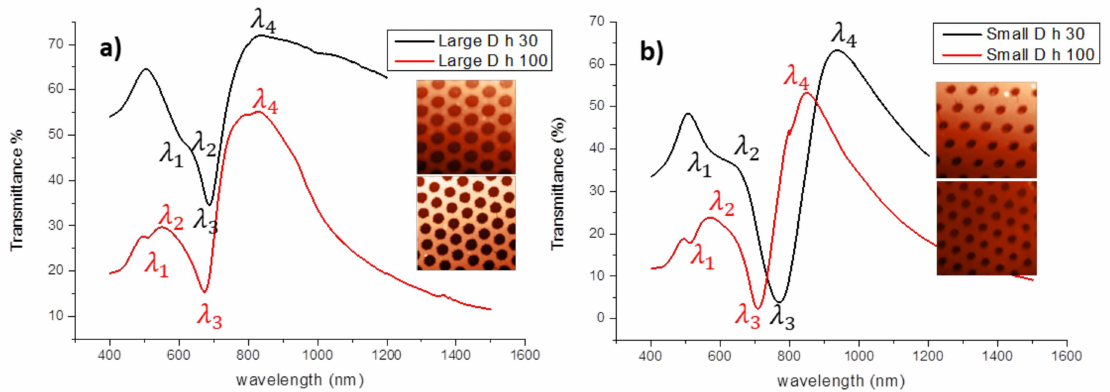
Figure 3. Optical transmittance spectra of the four samples in air, normalized to the signal of a bare glass substrate: ( a ) transmittance spectra of the large diameters nanoholes in gold film, 30 nm and 100 nm thick, respectively, ( b ) transmittance spectra of the small diameters nanoholes in gold film, 30 nm and 100 nm thick, respectively. λ 1 , λ 3 , indicate the weak and the very sharp minima, respectively, λ 2 , λ 4 indicate the weak and the marked maxima,